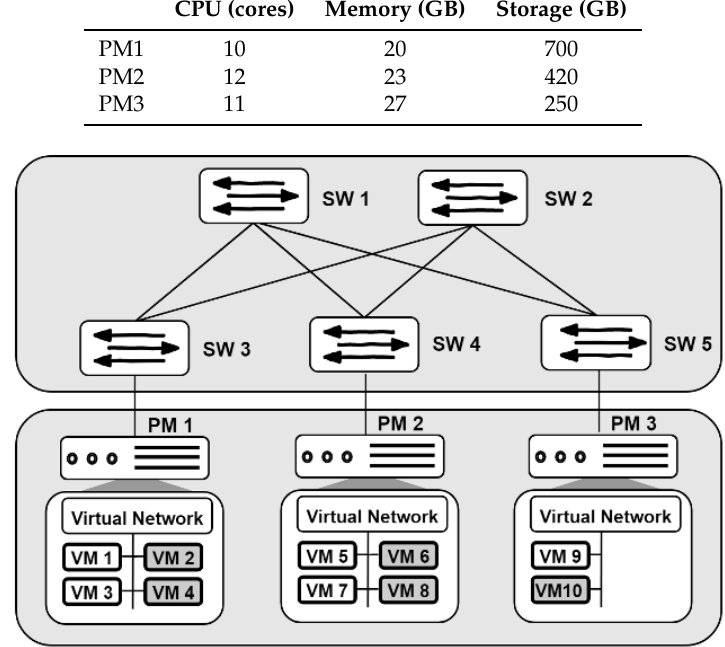
Figure 5. Simple data center network topology.